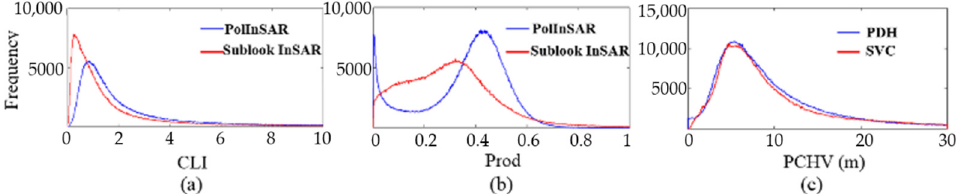
Figure 10. Histograms of the indexes ( a ) CLI, ( b ) prod, and ( c ) PCHV derived by the PolInSAR RVoG method (blue curves) and InSAR TF-RvoG method (red curves) in the single-baseline case. (2) Correction of the residual ground scattering error: The 1-D ambiguous error of